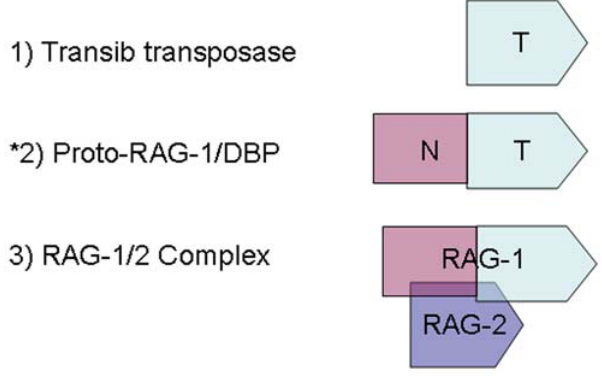
Figure 6. The hypothesis that a herpes DBP-like protein and RAG-1 protein have a modular architecture with structural and functional homology of functions is presented. Primordial RAG-1 protein (denoted pR1) has a carboxyl region structurally similar to a transib transposase (denoted T for Transib-like region structure # 1), but extra amino terminus protein sequences that may be derived from another protein family (denoted N). Herpes DBP are magnesium dependent recombinases are also modular proteins with an amino terminal regulatory region (denoted N), and a carboxyl terminus that binds to DNA. The RAG-1 protein currently requires a physical association with the RAG-2 protein for recombinase activity in vivo , but may have initially exhibited recombinase properties without RAG-2 analogous to the DBP. As discussed in the text, primordial RAG-2 protein (denoted pR2) may initially have blocked the recombinase functions of pR1 but exposed immunologic determinants essential to herpes virus immunity since the DBP are a major herpes virus antigen. Both Herpes DBP and RAG-1 also require an association with host cell factors such as DNApk and ku shared with the RAG proteins for viral recombinase activity in vivo as discussed in more detail in the text.